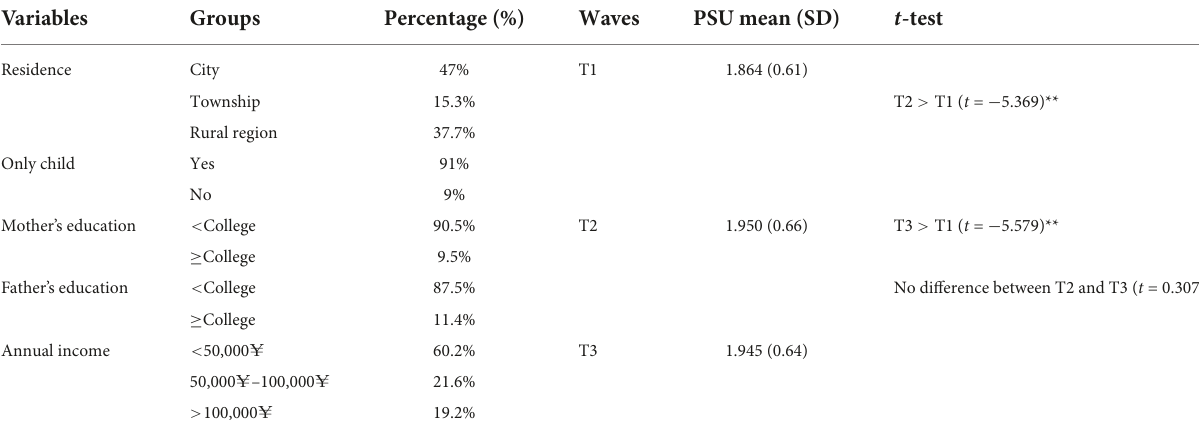
TABLE 1 Demographic information and descriptive